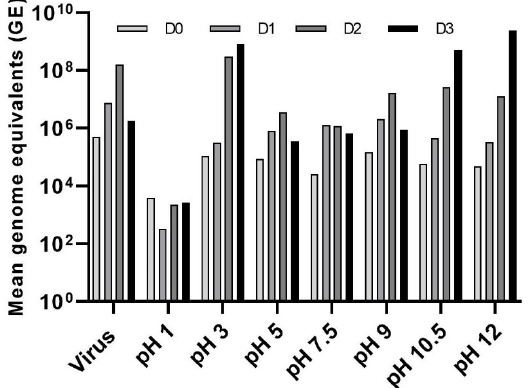
Figure 6. Absolute quantification of LJV following pH pre-treatment and oral delivery to adult Ds flies. The control (LJV without pH pre-treatment) is shown on the x-axis as “Virus” followed by the pH pre-treatment groups. The viral load was measured from day 0 to day 3 (D0–D3).